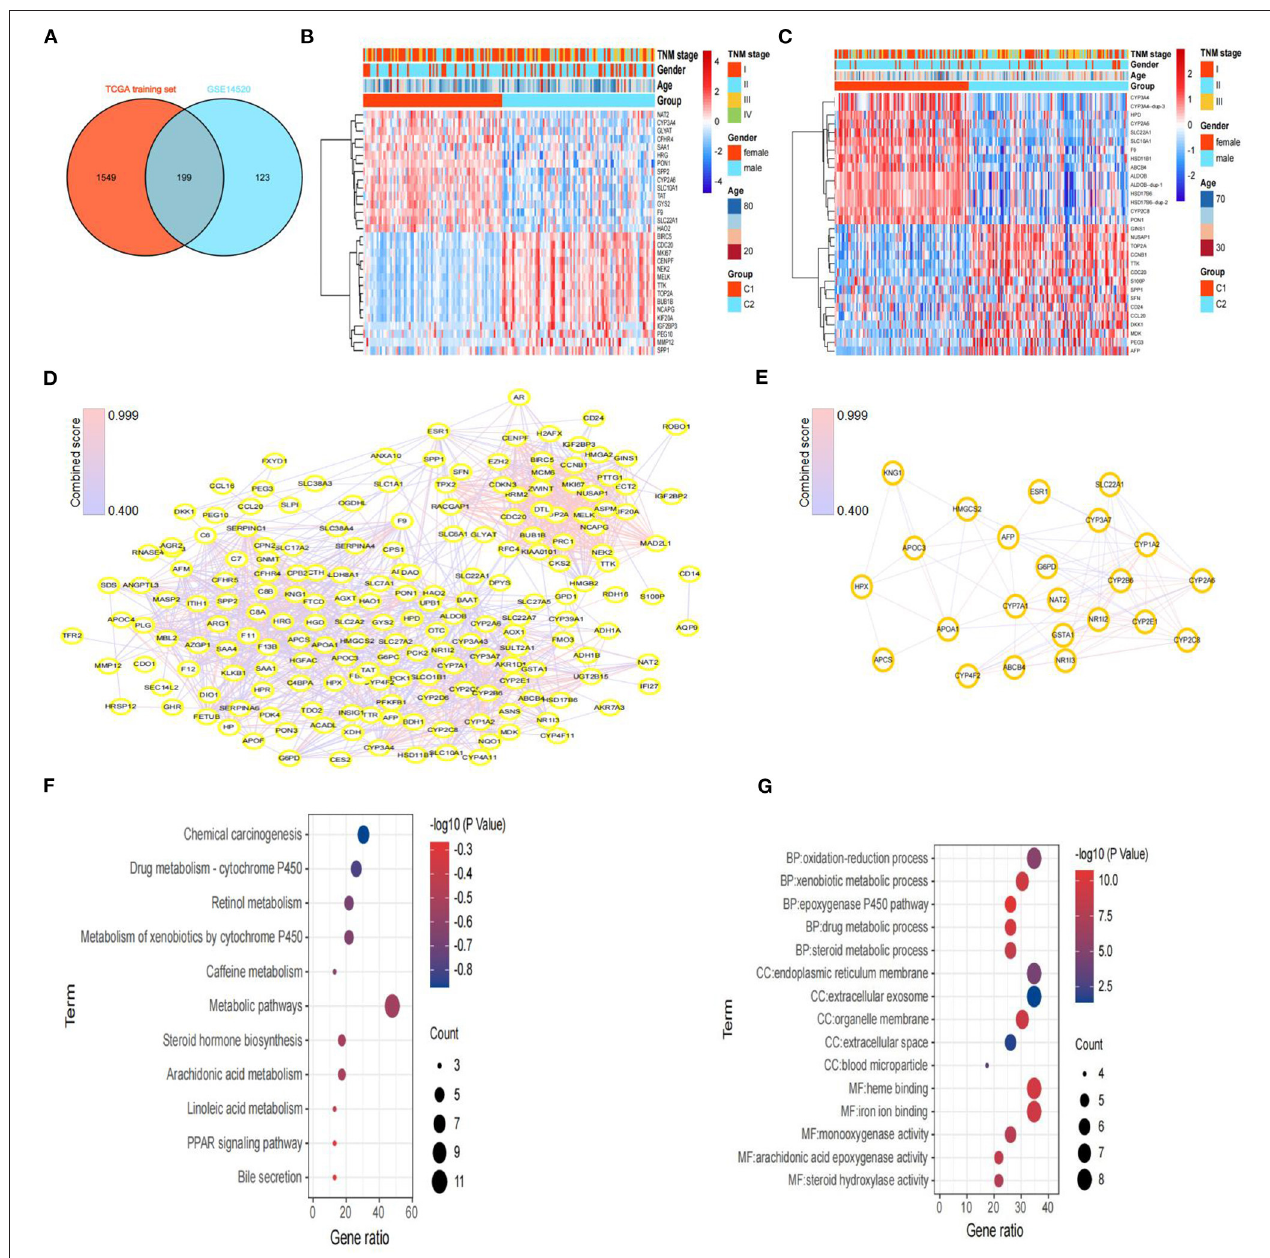
FIGURE 4 | Screening of DEGs and hub genes between subtypes and functional enrichment analysis. (A) Venn diagram of DEGs between subtypes from the TCGA training set and DEGs from GSE14520. (B) Heatmaps of the top 30 DEGs between C1 and C2 in the TCGA training set. (C) Heatmaps of the top 30 DEGs between C1 and C2 in GSE14520. (D) Protein–protein interaction (PPI) network based on the 199 DEGs, constructed via STRING. (E) The PPI network of subnet 3 (hub genes) through MCODE. (F) The results ( p < 0.05) of KEGG analysis based on hub genes. (G) The top 5 results of GO analysis (BP, biological processes; CC, cellular components; and MF, molecular functions) based on hub